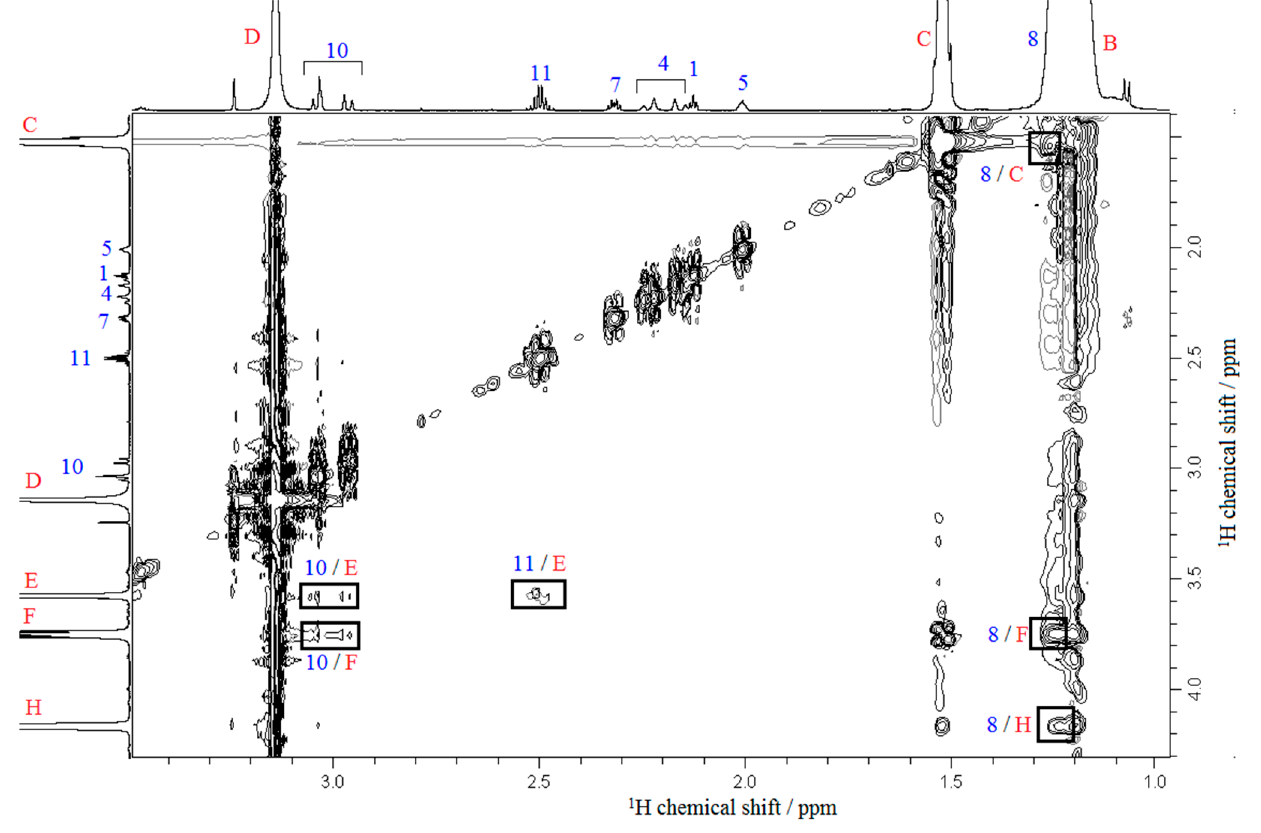
Figure 6. The fragment of 2D NOESY NMR spectrum of compound 4 in DPC solution at 300 K. Numbers designate protons of compound 4, letters B–H belong to DPC protons. Intermolecular cross-peaks are highlighted by bold black frames.